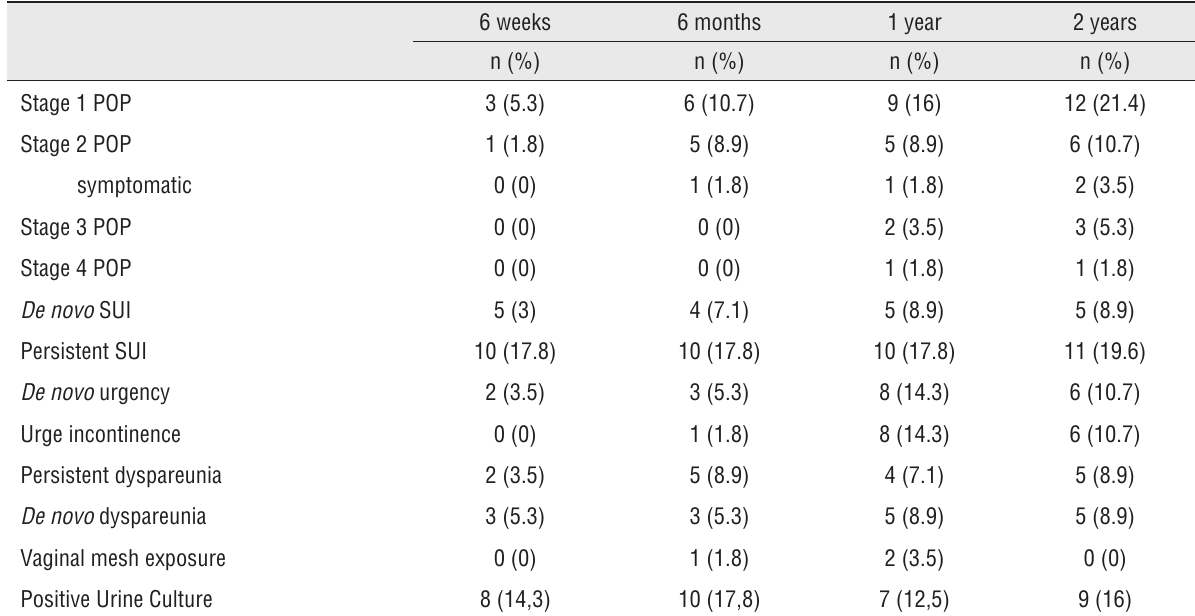
Table 2 - Anatomical pOp-q results and complications at follow-up.